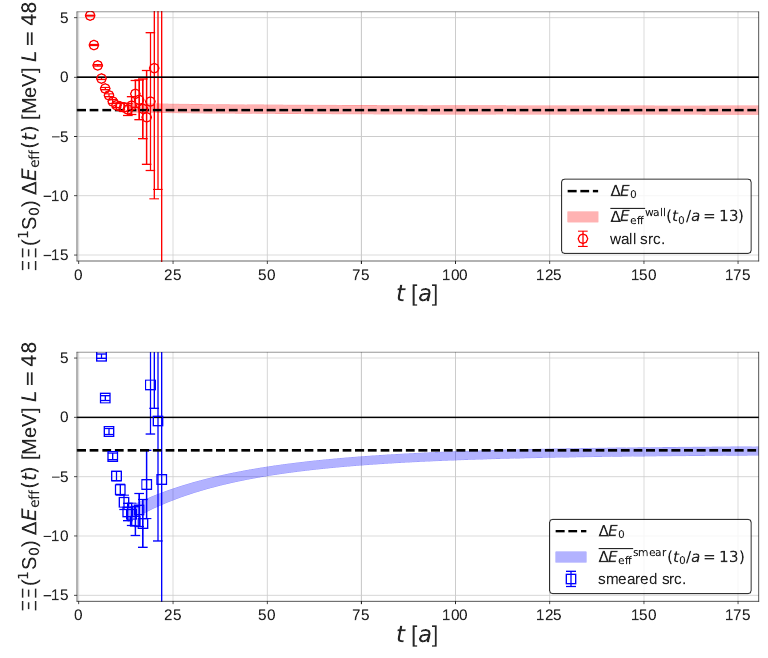
Figure 11 . The same as (cid:12)gure 10 but for the wider range of the Euclidean time t